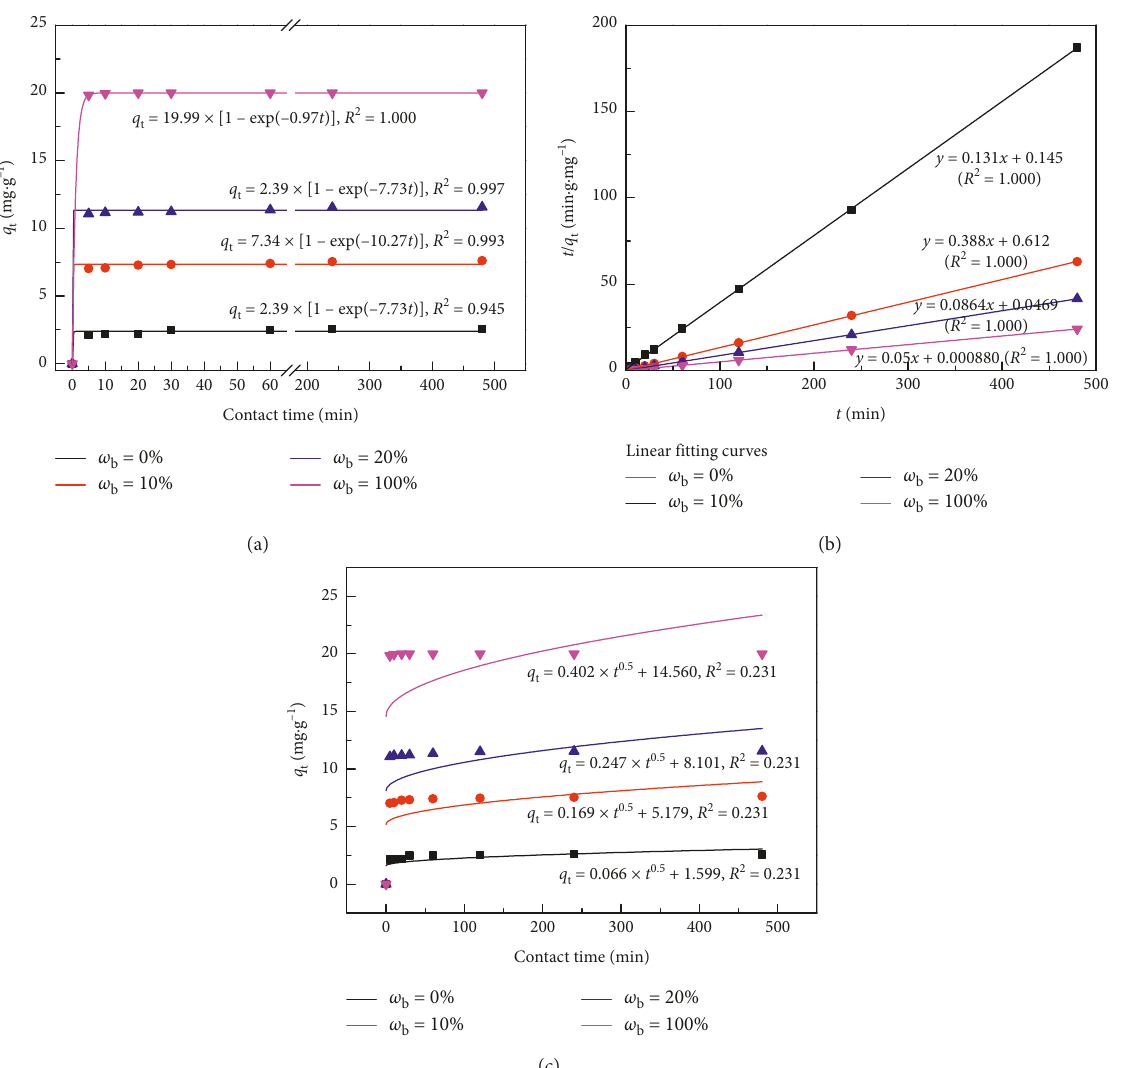
Figure 2: Pb(II) adsorption kinetics plots of laterite-bentonite mixtures: (a) pseudo-first order; (b) pseudo-second order; (c) intraparticle